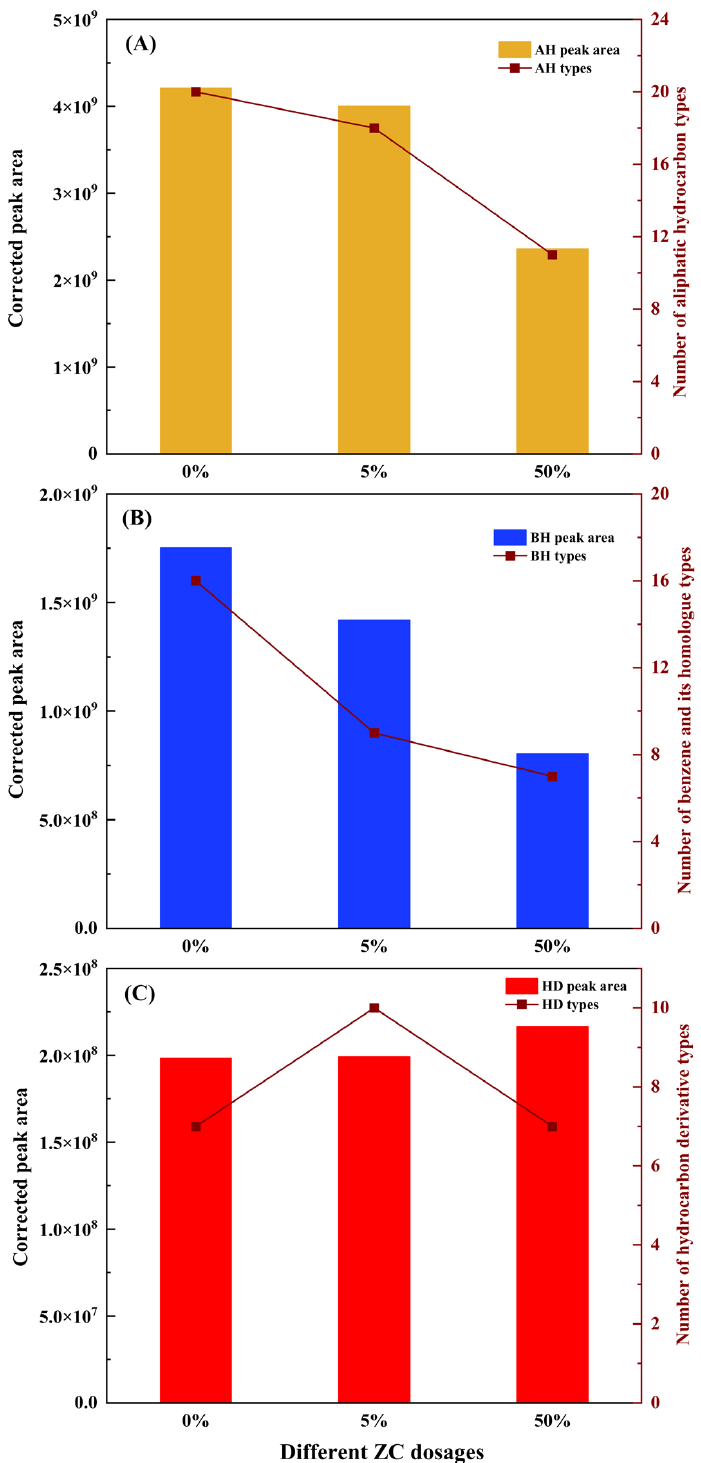
Figure 7. Adsorption effect of different asphalt VOCs types: ( A ) AH; ( B ) BH; ( C ) HD.